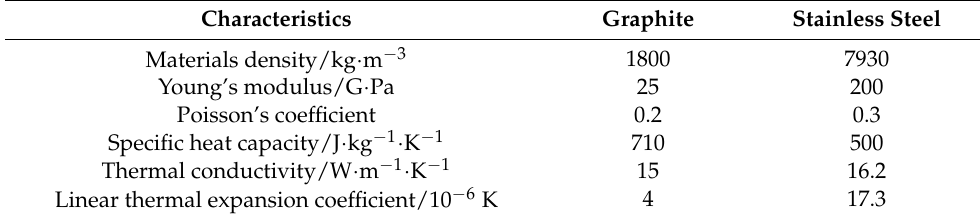
Table 1. Parameters of ring materials.